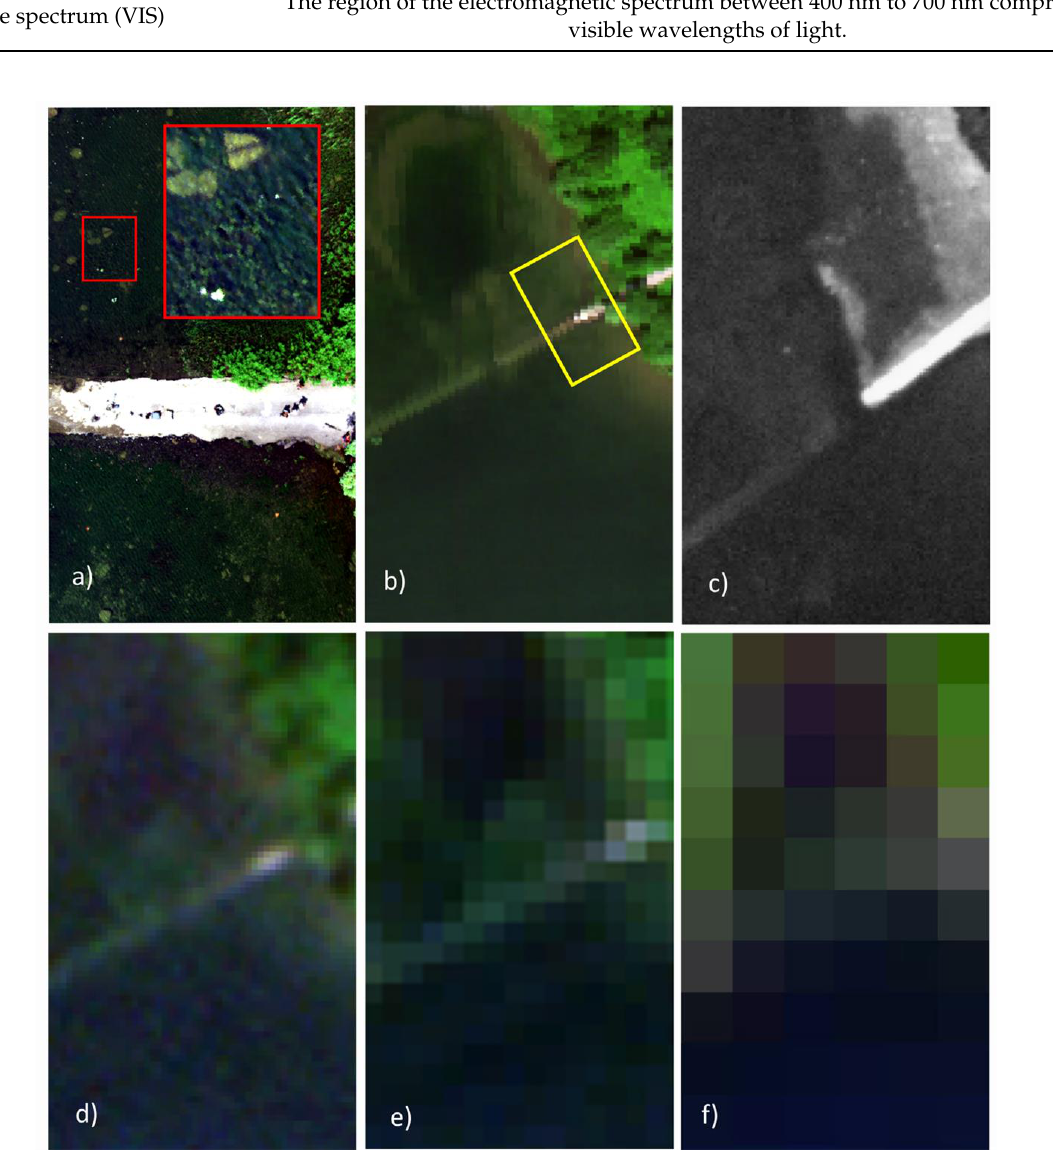
Figure 2. Comparison of spatial resolutions in representing natural and man-made features (most notably a flooded road) in the Saint-Lawrence River, Ontario, Canada. ( a ) 3 cm resampled pixel size image acquired from an unmanned aerial vehicle (UAV) platform with the uCASI sensor (288 spectral bands). Subset is shown as a true color composite R:648 nm/G:548 nm/B:449 nm. ( b ) 1 m resampled pixel size image acquired from an airborne hyperspectral platform (CASI-1500, 288 spectral bands) Subset is shown as a true color composite R:641 nm/G:550 nm/B:471 nm. The yellow box indicates the spatial extent of frame ( a ). ( c ) Panchromatic film photograph from a KH-9 satellite taken in 1980 at a spatial resolution of 2 to 4 feet. ( d ) 3 m resampled pixel size image from the commercial PlanetScope satellite constellation (Dove-PS CubeSat). ( e ) 10 m resampled pixel size Sentinel-2 satellite image. ( f ) 30 m resampled pixel size Landsat image. For d-f, the respective RGB bands are displayed as true color composites.